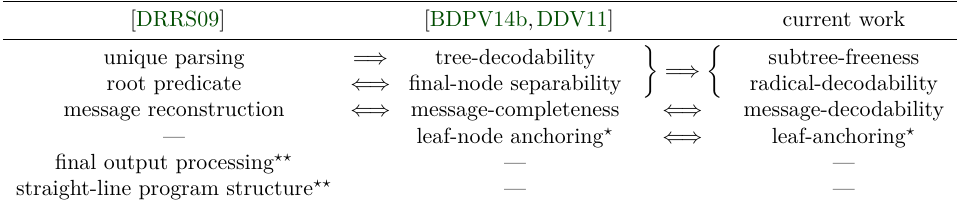
Table 2: Sufficient conditions from Dodis et al. [DRRS09], Bertoni et al. [BDPV14b], Daemen et al. [DDV11], and current work. The order of the conditions in the earlier works is reshuffled for sake of